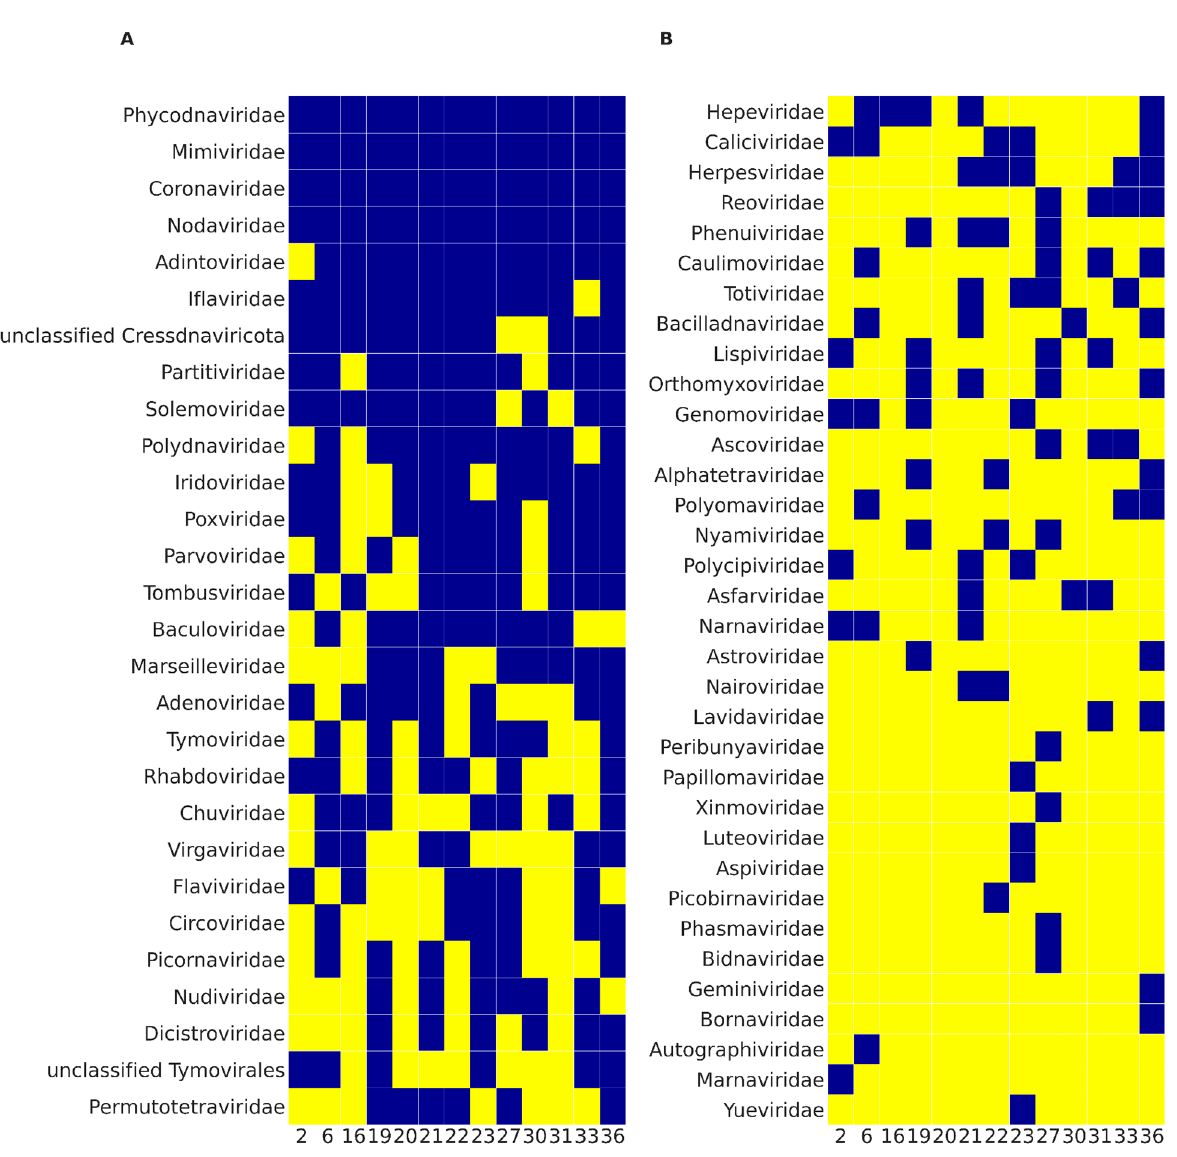
Figure 2. Presence of reads of viral genomes in bat samples in terms of the results of total sequencing. ( A ) Viral families in which reads were detected in at least six independent samples. ( B ) Viral families in which reads were detected in five or fewer samples. Blue rectangles correspond to the presence of the related viruses in the sample, yellow rectangles correspond to the absence. Numbers at the bottom represent bat samples.